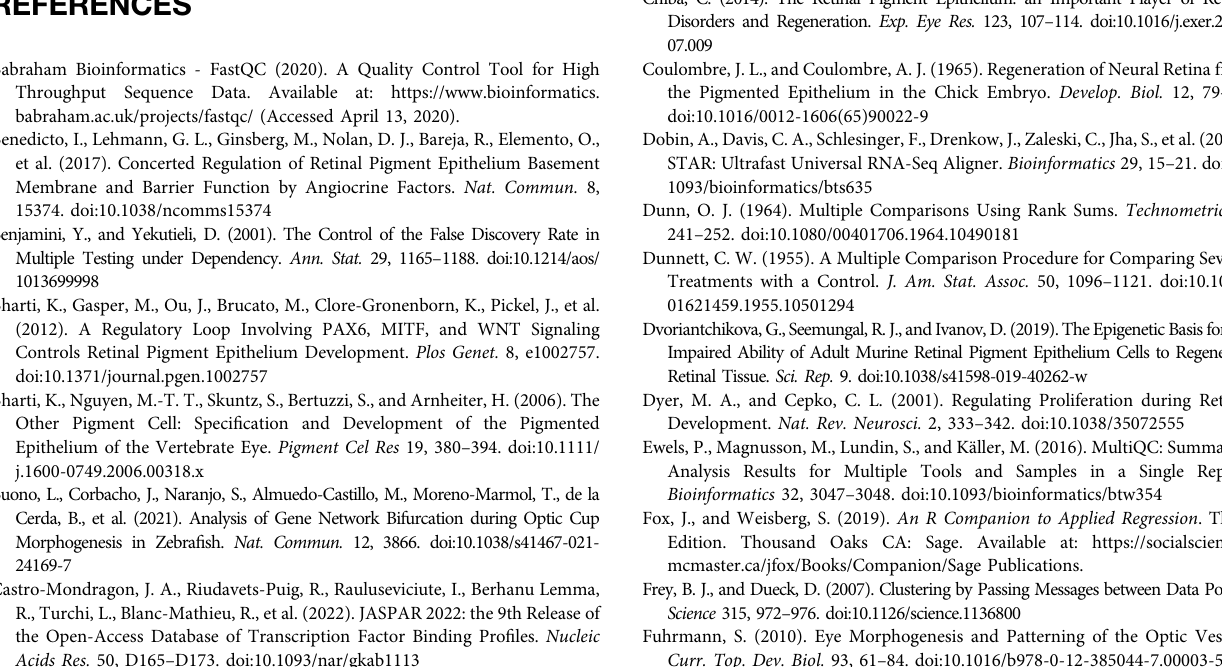
Supplementary Figure 5 | Changes in gene expression and accessibility re fl ect RPE maturation across the E4 to E5 window. GSEA of RNA-seq gene expression normalized enrichment scores of 2.5105283 and 2.2099848, respectively. (C) GSEA analysis of intact E4 and E5 RPE reveals a high normalized enrichment